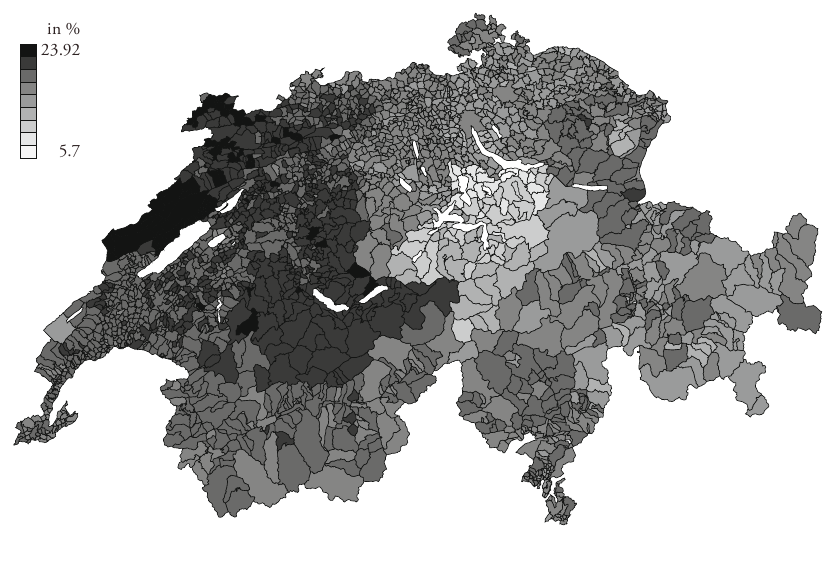
Figure 4: Consolidated cantonal (cid:2) municipal effective average tax rate across Swiss municipalities in 2014 for a married couple with two children and top-1% income. in % 23.92